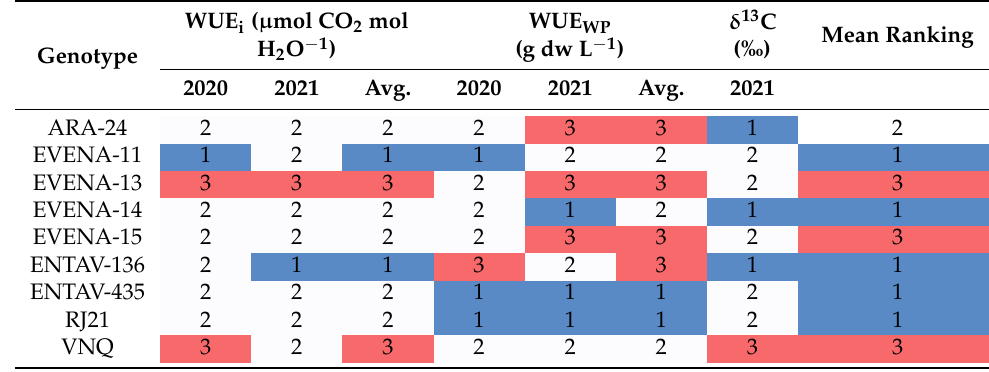
Table 6. Ranking according to the measurements of whole plant water use efficiency (WUE WP ), intrinsic water use efficiency (WUE i ) and carbon isotope ratio in grapes ( δ 13 C) for the 9 “Grenache” genotypes grown in Mallorca,